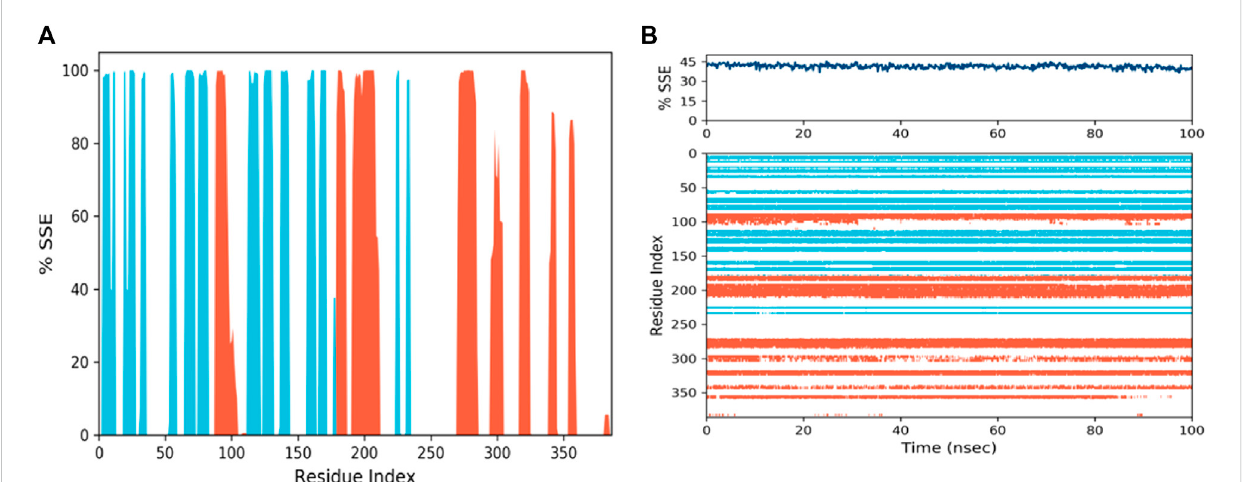
FIGURE 7 Visualization of the secondary structures of alpha helices, beta-strands, and other secondary structures in protein structure. (A) SSE distribution by residue index: red peaks = helices, blue peaks = beta-strands. (B) SSE composition for each trajectory frame and assignment for each residue over time.